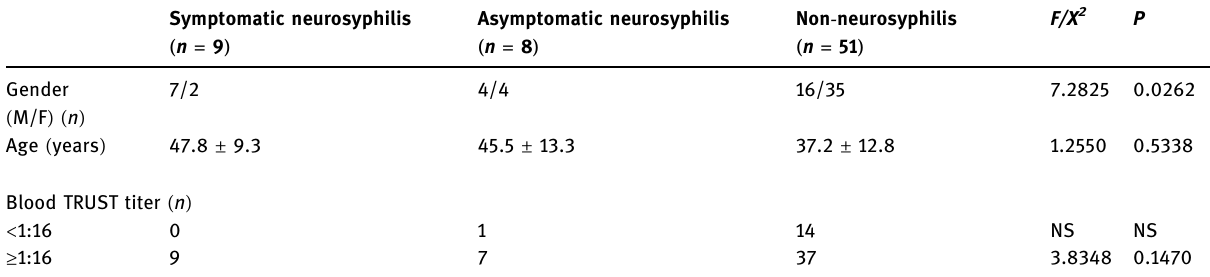
Table 2: Sixty - eight patients ’ characteristics in the treatment failure group Symptomatic neurosyphilis ( n = 9